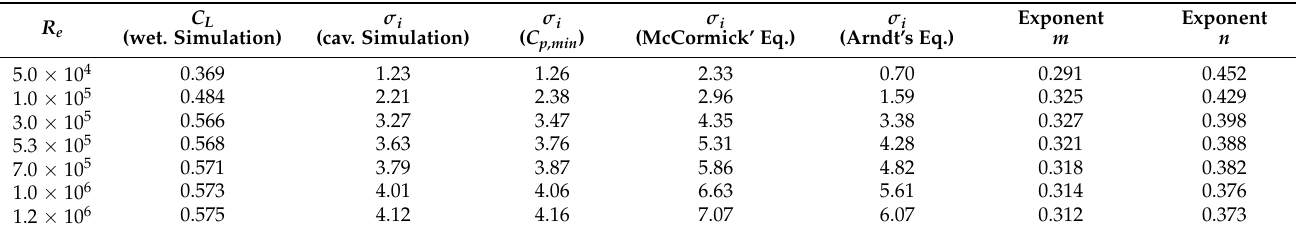
Table 2. Cavitation inception numbers and scaling index variations in weak water. R